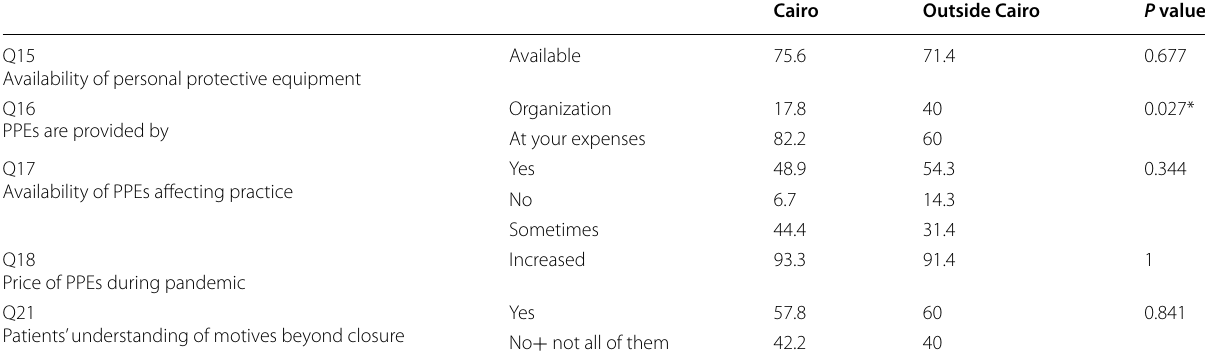
Table 6 Comparison between the percentages of the responses of phoniatricians located in Cairo and outside Cairo regarding some economic